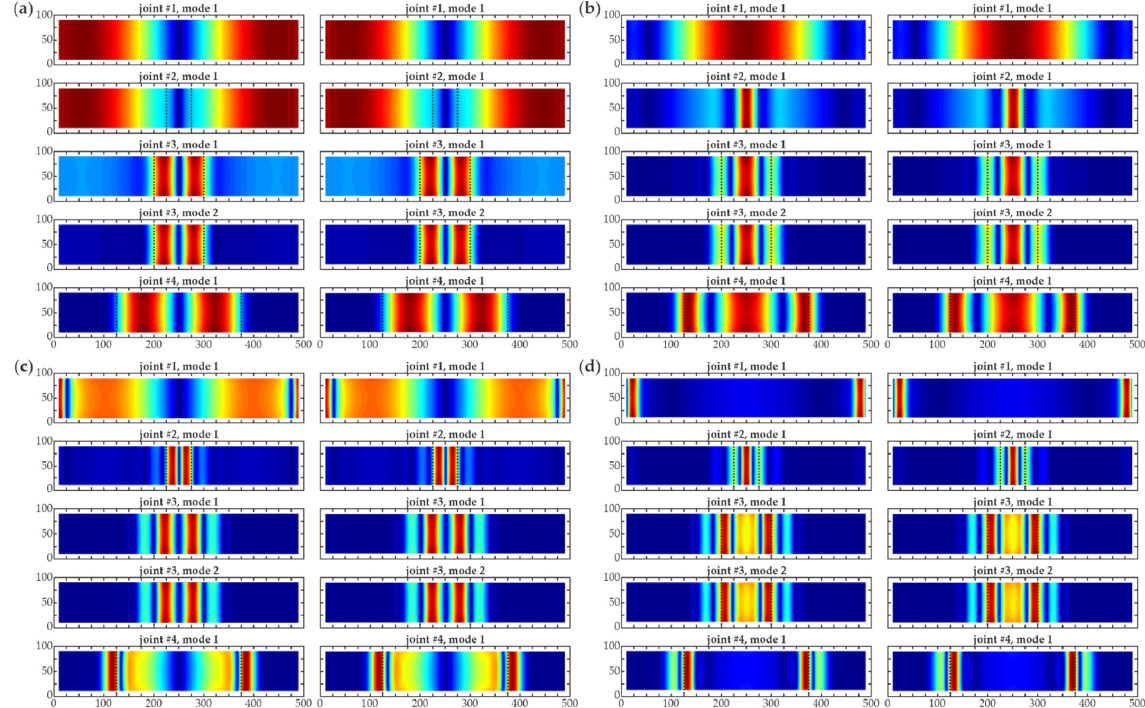
Figure 8. Comparison of CWT damage imaging for numerical results (left column—mesh 2 mm, no additional interpolation and right column—grid 20 mm interpolated to 2 mm, both for scale s = 8) for all joints #1–#4 (dimensions in [mm]) using different wavelets: ( a ) gaus1 ; ( b ) gaus2 ; ( c ) gaus3 ; ( d ) gaus4 .